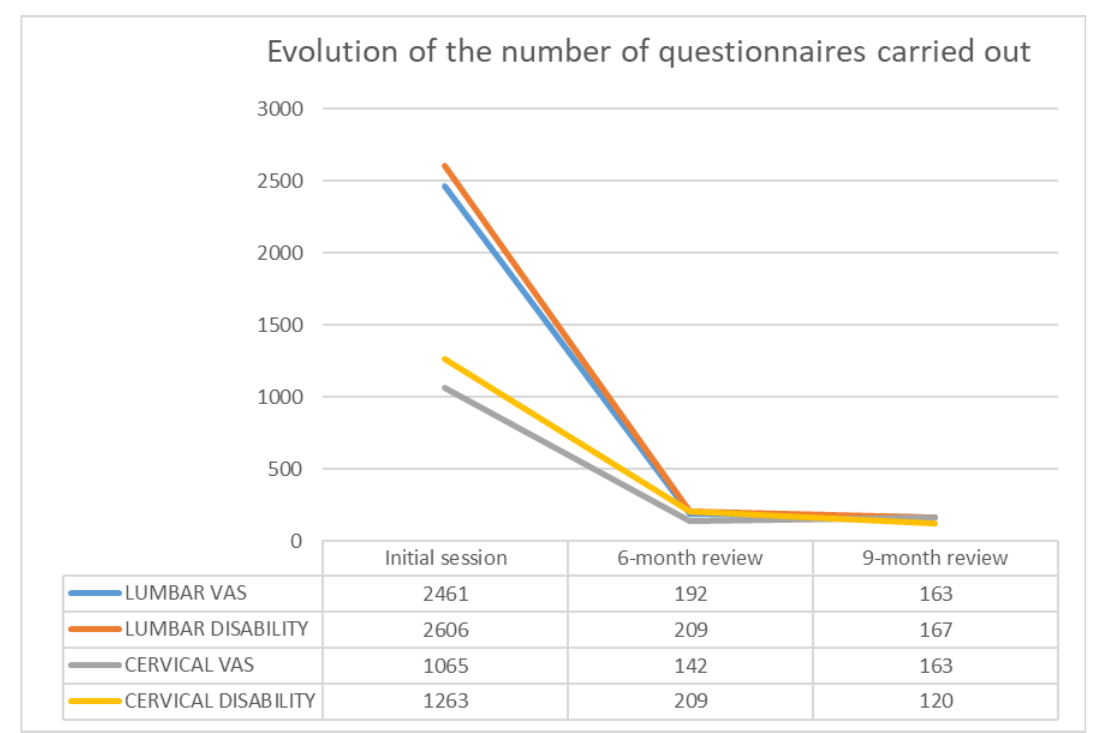
Figure 1. Time evolution in the number of questionnaires, in the 1st evaluation of the BS, 2nd review at 6 months and 3rd review at 9 months.